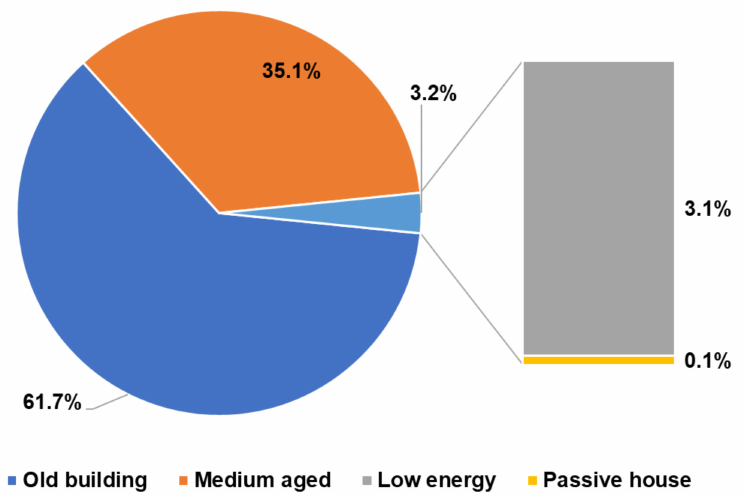
Figure 5. Weights for the building models and estimated built-age distribution according to building standard in